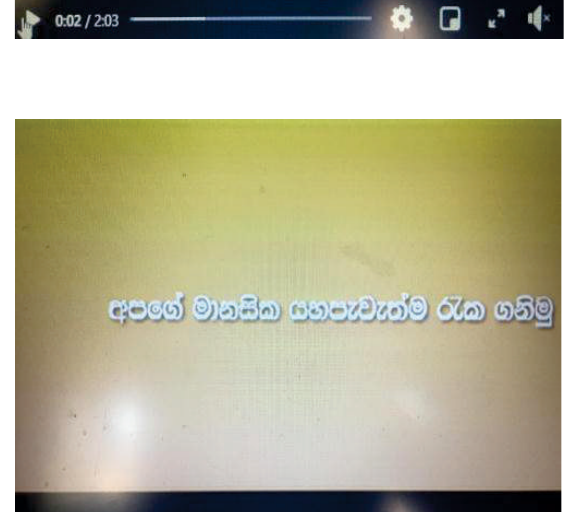
Figure 2: Video clips to promote mental health during COVID-19